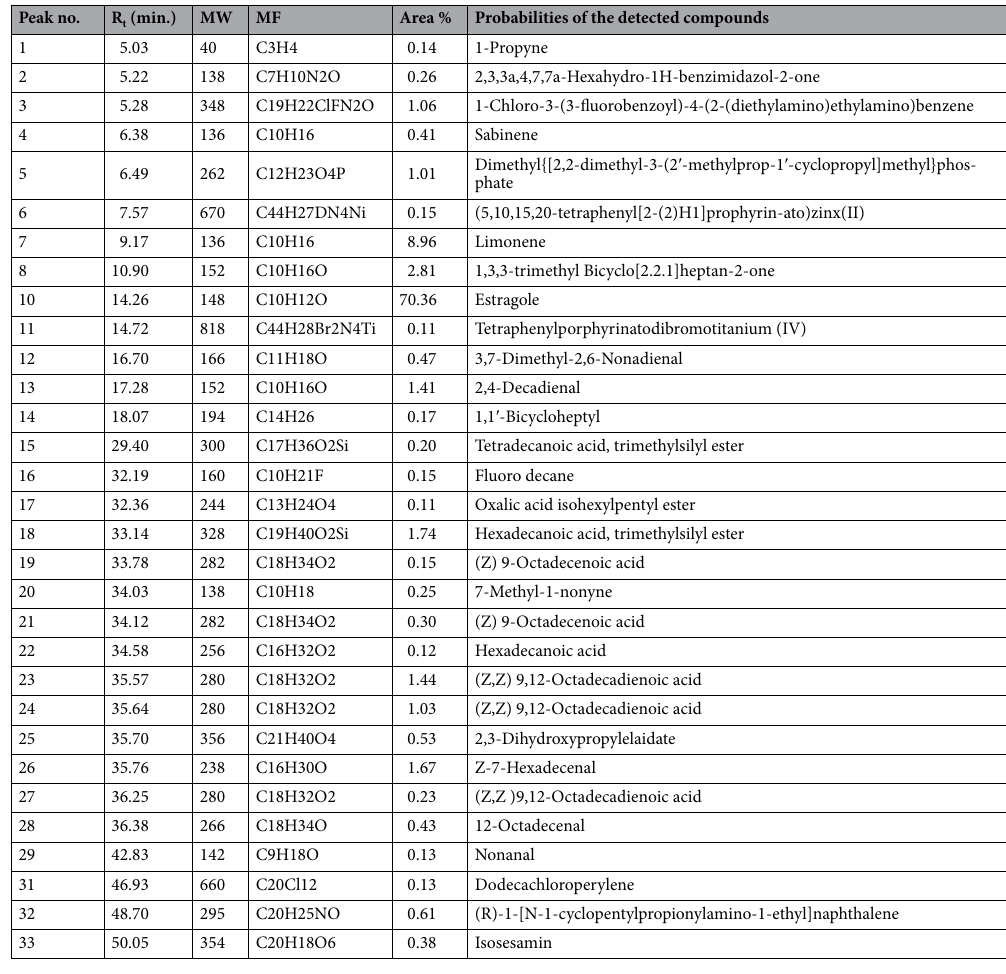
Table 7. GC/MS analysis of the Foeniculum vulgare Mill.